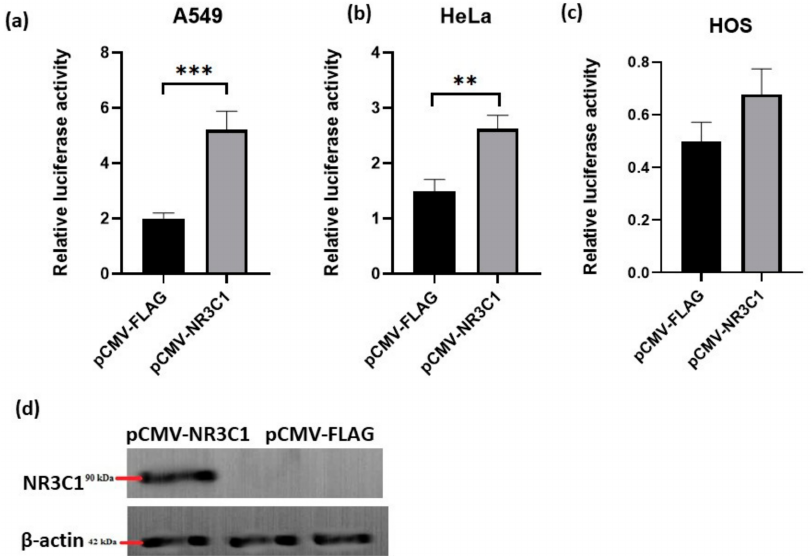
Figure 1. Overexpression of gluccocorticoid receptor causes activation of RANKL promoter in A549, HeLa and HOS cells. ( a ) A549, cells were co-transfected with the luciferase reporter constructs harboring RANKL promoter region 889 bp, (pGL3-RANKL100), and 24 h after transfection luciferase activity was measured. Relative luciferase activity is shown and it was calculated by normalization of Firefly luciferase activity to Renilla luciferase activity. ( b ) HeLa cells were co-transfected with the luciferase reporter constructs harboring RANKL promoter region 889 bp, (pGL3-RANKL100), and 24 h after transfection luciferase activity was measured. ( c ) HOS cells cells were co-transfected with the luciferase reporter constructs harboring RANKL promoter region 889 bp, (pGL3-RANKL100), and 24 h after transfection luciferase activity was measured. ( d ) Expression of overexpressed protein was confirmed by Western blot using anti-FLAG antibodies. β -actin was used as a loading control. All the experiments were performed at least three times independently in parallels. The results are expressed as the mean ± SEM. **– p < 0.01, ***– p <